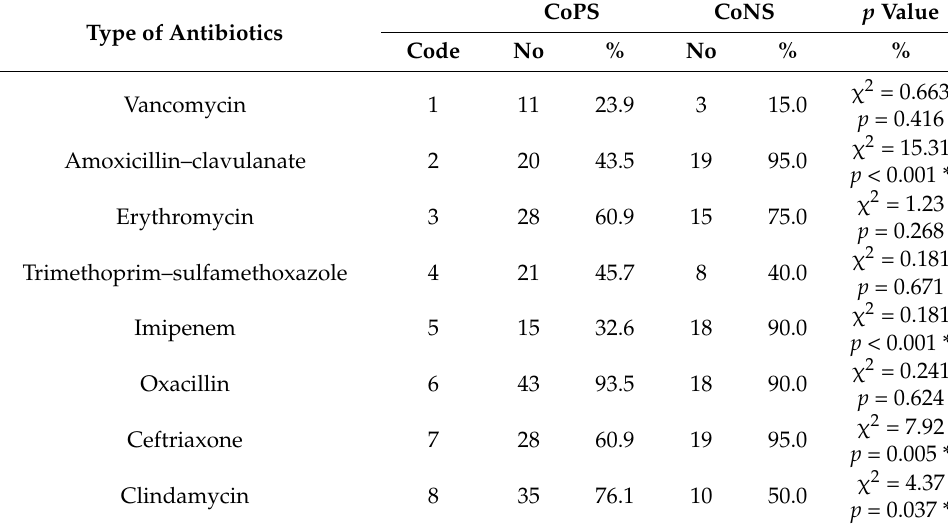
Table 2. Mapping resistance extent (%) within the Staphylococcus isolates collected from patients. Type of